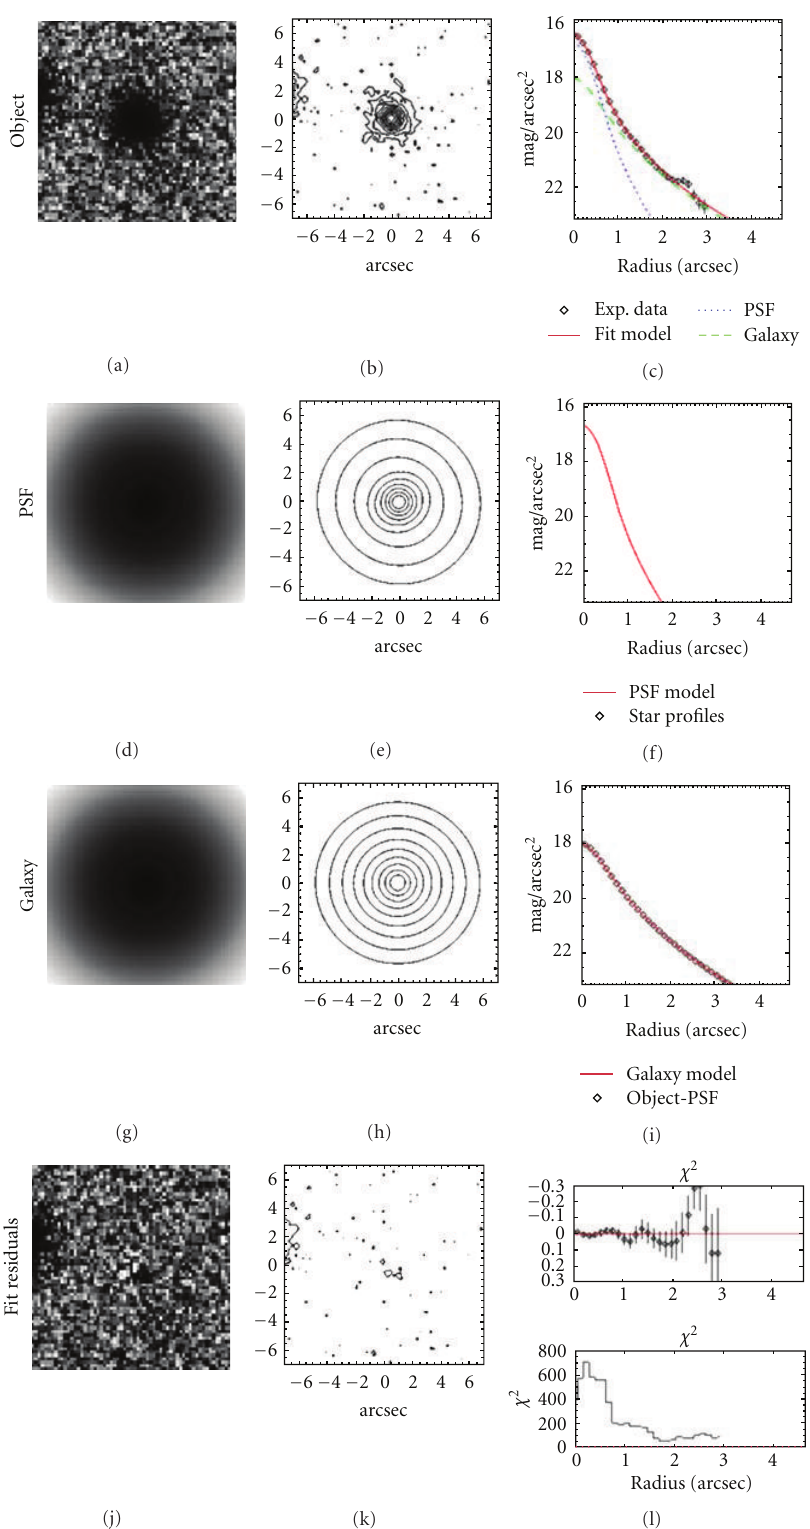
Figure 3: An example of the analysis of the quasar host galaxies, shown in the case of the quasar J08285 + 2748. Top panels: observed quasar image (left), contour plot (center), and light profile (right; the PSF and galaxy models are plotted in dotted and dashed lines, resp.). Central panels: similarly, the images (left), contour plots (center), and light profile (right) of the PSF and the galaxy model. Bottom panels: image (left), contour plot (center), and light profile (top right) of residuals after model subtraction. The radial distribution of χ 2 values is also plotted (bottom